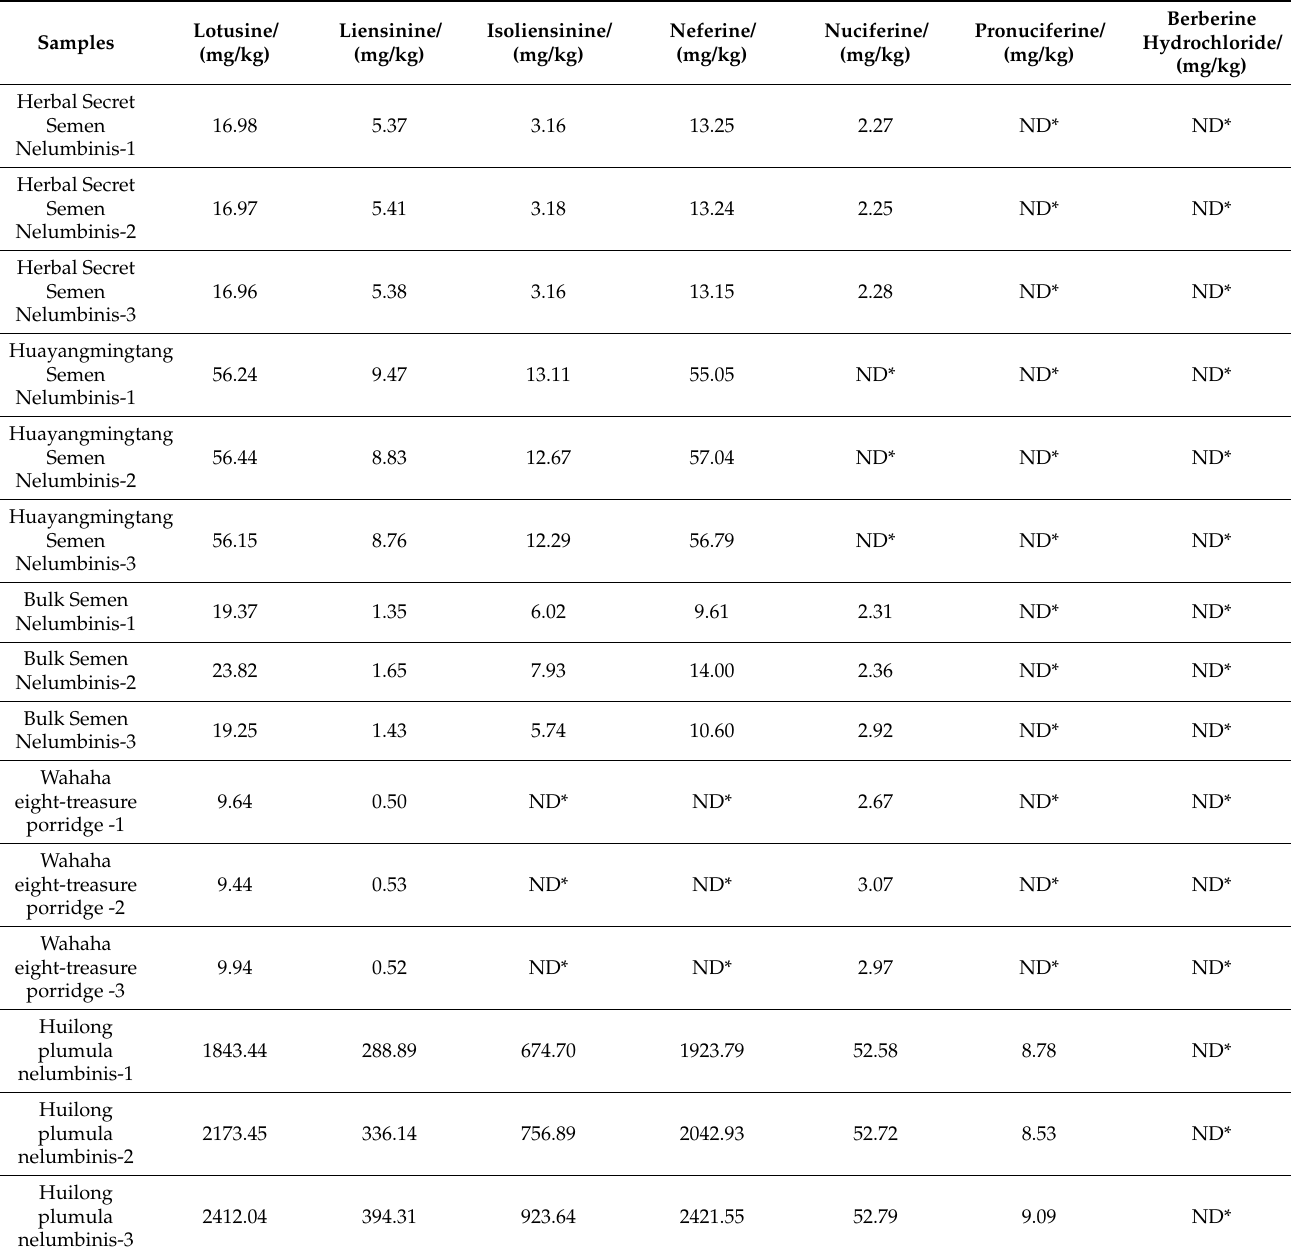
Table 6. Determination of 7 kinds of alkaloids in different